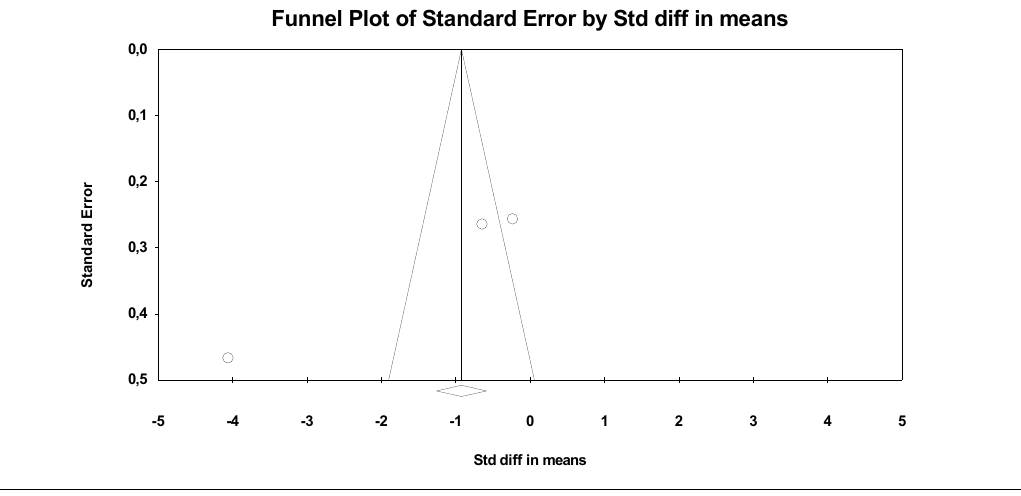
Figure 4. Funnel plot for endpoint MDA (SMD) in present meta-analysis.